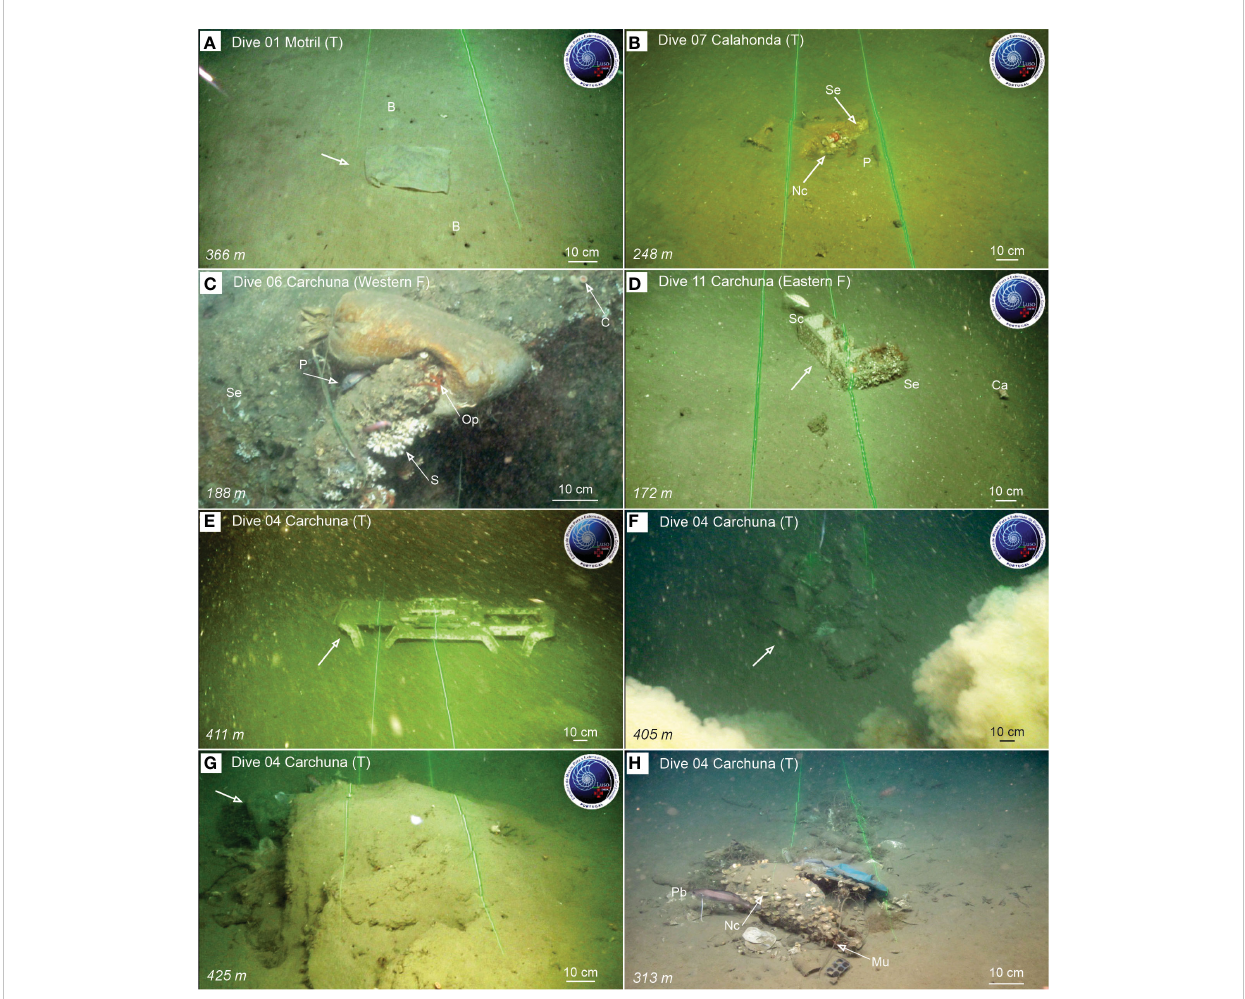
FIGURE 5 Examples of litter items observed during ROV dives in the Motril, Calahonda, and Carchuna canyons, and litter accumulations found in Dive 04 along the thalweg of the Carchuna Canyon. Dive number, water depth and relative location within the canyons (T, canyon thalweg; F, canyon fl ank) are indicated. (A) Plastic bag (arrow) on the thalweg of the Motril Canyon. (B) Two concrete blocks used in longline fi shing as weights, colonized by serpulid polychaetes and N. cochlear aggregations, together with two P. bogaraveo individuals as well as a soda can and small plastic fragments on the thalweg of the Calahonda Canyon. (C) A fi lled plastic bag (used as weight in longline fi shing) on rocks colonized by unidenti fi ed colonial scleractinians, serpulid polychaetes and Ophiotrix sp., together with individuals of the black-spot seabream Pagellus bogaraveo (one of the target species of longline fi shing). (D) Two bricks colonized by serpulids on the eastern fl ank of the Carchuna Canyon, with some fi shes ( Serranus cabrilla and Capros aper ). (E) Sunbed over the sea fl oor on the thalweg of the Carchuna Canyon. (F) Accumulation characterized by a large number of bottles. (G) Accumulation composed of bottles, bags and fi shing nets blocked behind a sea fl oor rocky outcrop. (H) Accumulation with bricks, a broken sheet, various bags and bottles, fi shing nets, a metal tube and diverse plastic items, some of them colonized by N. cochlear , but also providing shelter to the greater forkbeard Phycis blennoides and Munida sp. B, Burrows made by decapods; C, Caryophyllia sp.; Ca, Capros aper ; Mu, Munida sp.; Nc, Neopycnodonte cochlear ; Op, Ophiothrix sp.; P, Pagellus bogaraveo; S, Scleractinians; Sc, Serranus cabrilla ; Se, Serpulid